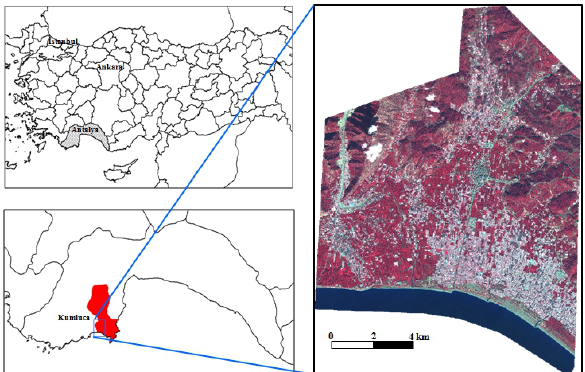
Figure 1. The study area that is located in Kumluca, Antalya, Turkey and color infrared composite of WorldView-2 satellite imagery for the selected study